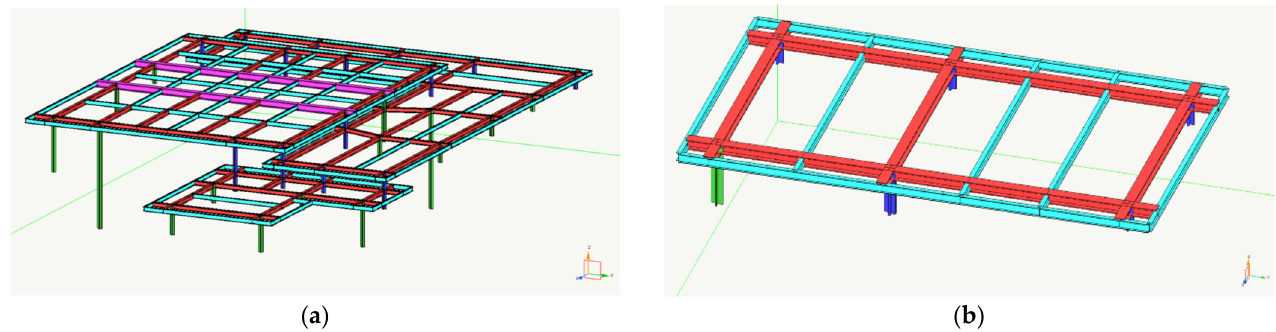
Figure 17. The structural models of the roofs. ( a ) Championnet n.1-2; ( b ) Championnet house at n.3.